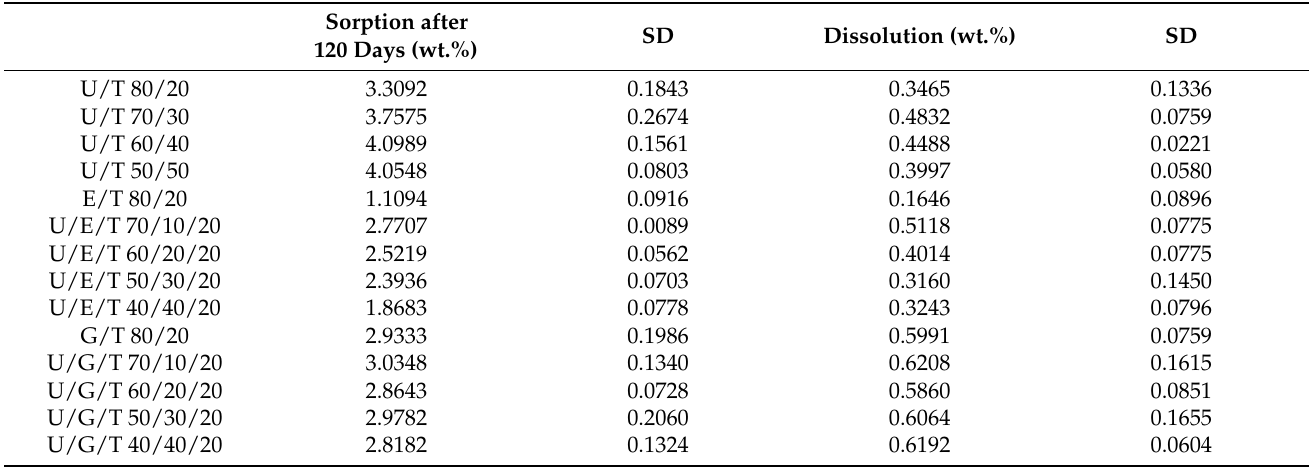
Table 4. The mean values of the water sorption, after 120 days, and dissolution (weight loss, absolute value) of the tested matrices with standard deviations